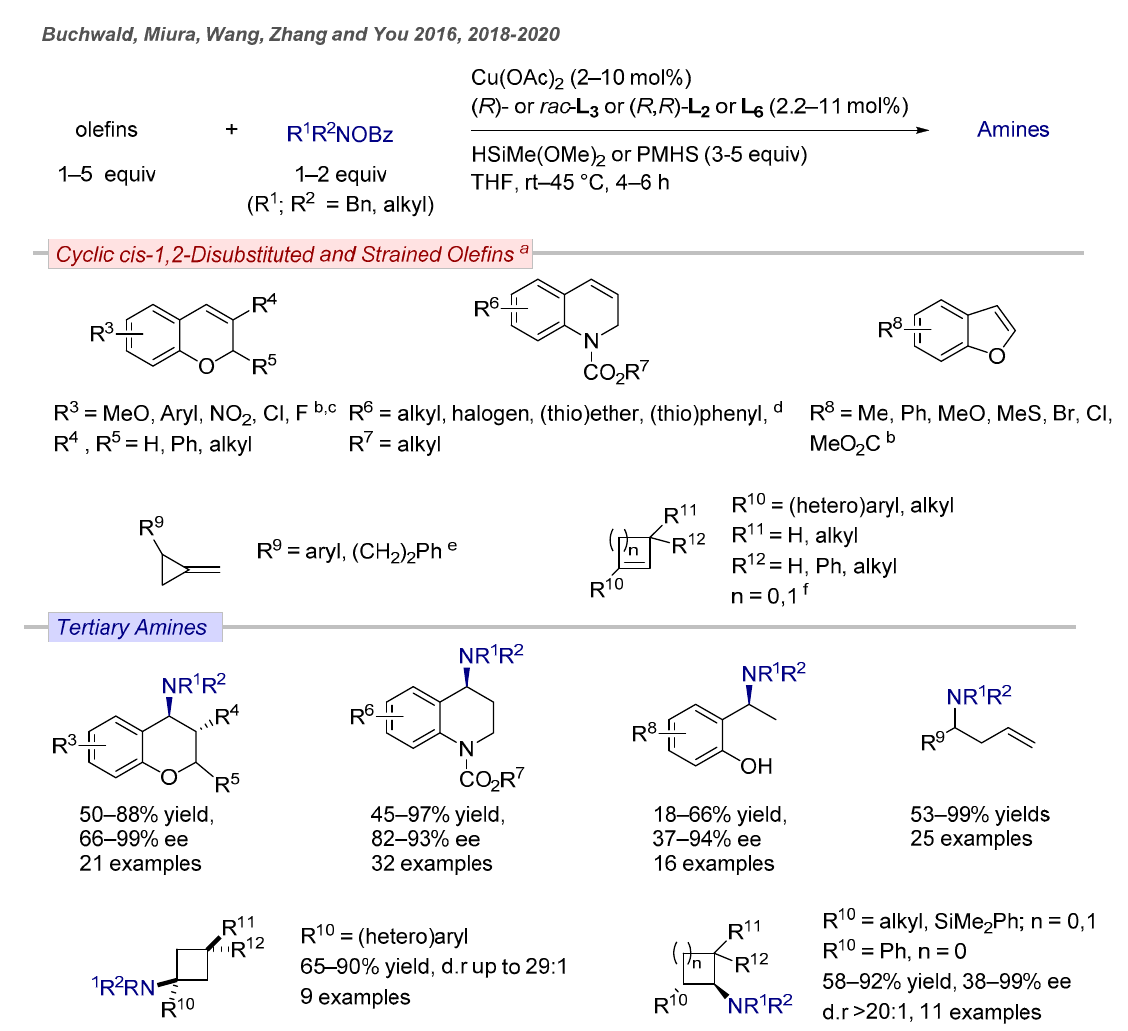
Figure 26. Regio- and enantioselective biphosphine · CuH-catalyzed hydroamination of alkene derivatives and electrophilic amines. a all reactions run with Cu(OAc) 2 , ( R )- L 3 , R 1 R 2 NOBz (R 1 ; R 2 = Bn, alkyl) in THF unless otherwise stated. b p - (10 mol%), LiO t Bu (4 equiv) in DCE. f 1,3,5-Me 3 C 6 H 2 CO 2 NR 1 R 2 or BzONR 1 R 2 or PivONR 1 R 2 . rt = room temperature, d.r = diasteromeric ratio, ee = enantiomeric